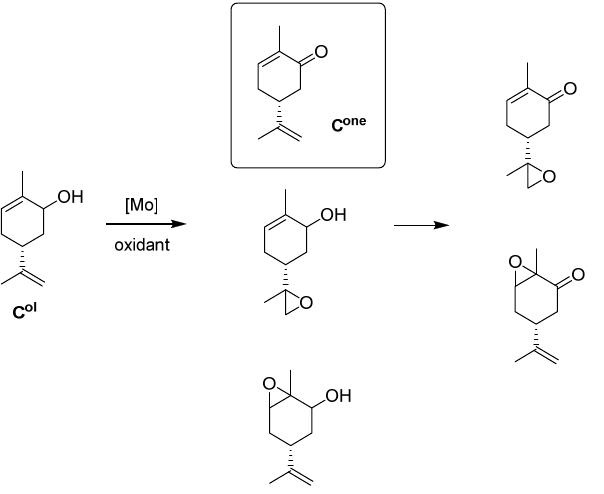
Figure 18. Schematic oxidation of carveol (C ol ) into carvone (C one ) and